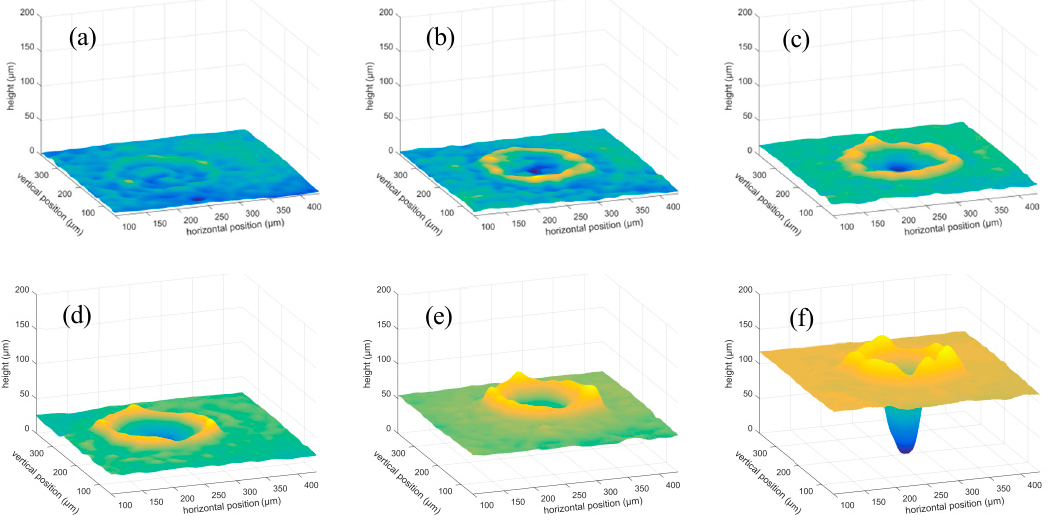
Figure 8. Ablation crater morphology after irradiation of 2 n (n = 0,1,2,3,4,5) pulses at substrate temperatures of 50 °C. (a) 1 pulse; (b) 2 pulses; (c) 4 pulses; (d) 8 pulses; (e) 16 pulses; (f) 32 pulses.